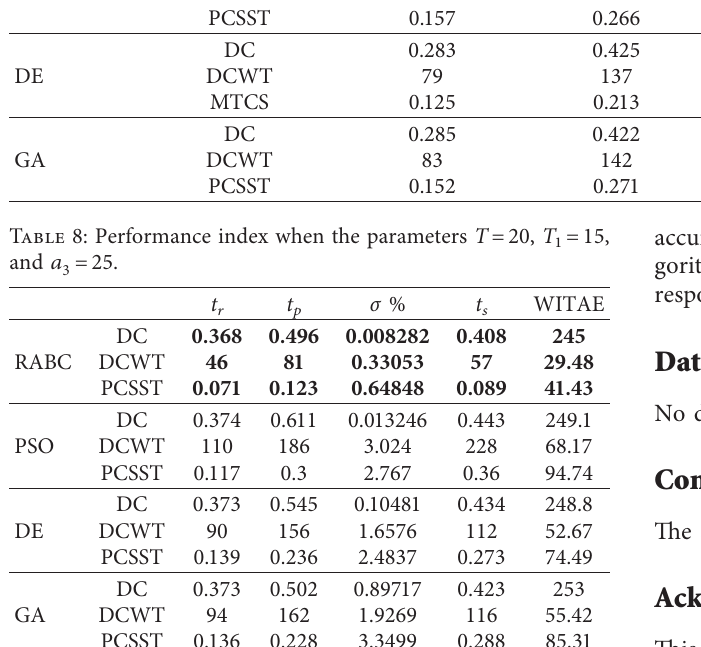
Table 7: Performance Index when the parameters T � 15, T